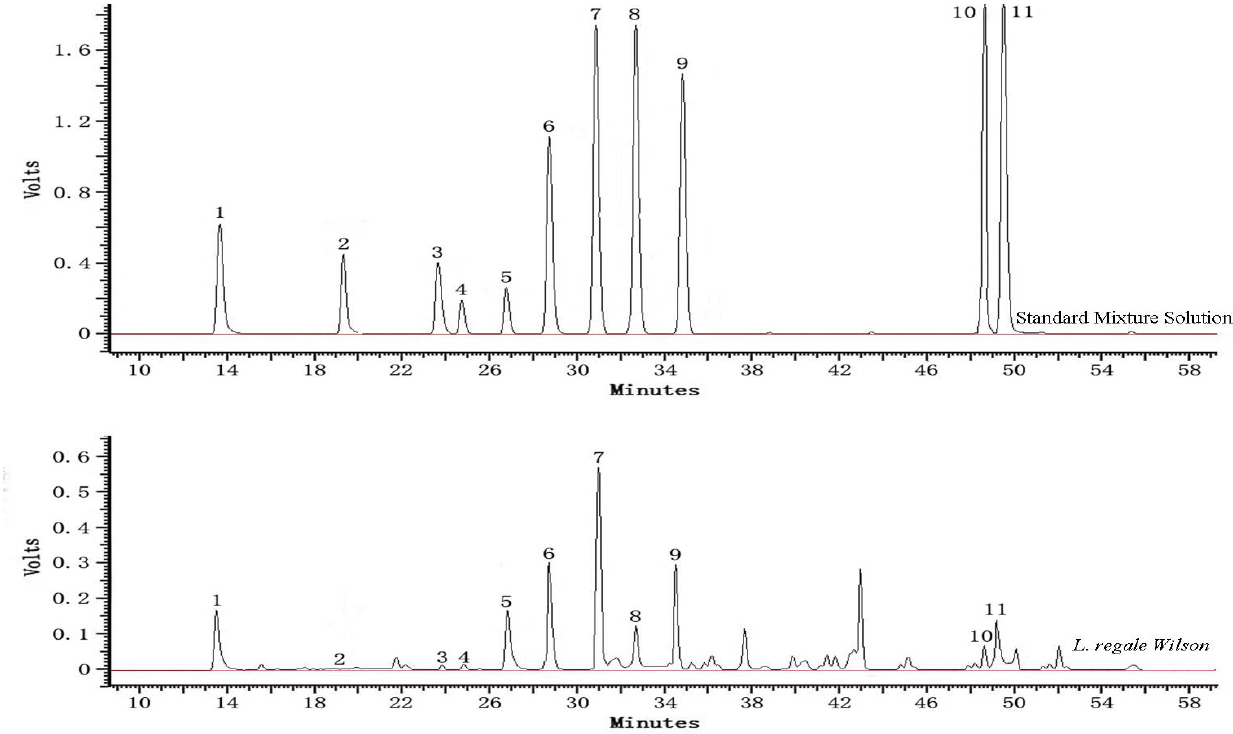
Figure. 1. HPLC trace of individual polyphenolic constituents (1, gallic acid; 2, rutinoside; 3, (+)-catechin; 4, chlorogenic; 5, ( − )-epicatechin; 6, myricetin; 7, rutin; 8, p -coumaric acid; 9, quercetin; 10, phloridzin; 11, kaempferol) of the standard mixture solution and L. regale